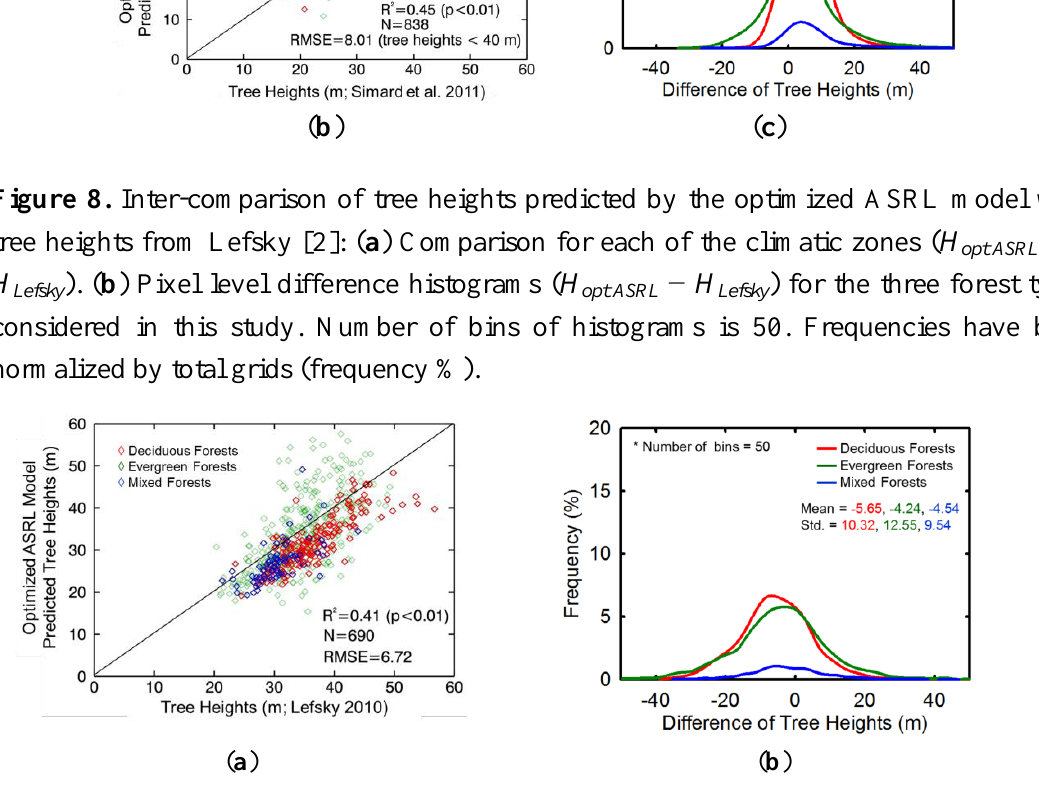
and opt ASRL − H ) for the three forest types opt ASRL Lefsky